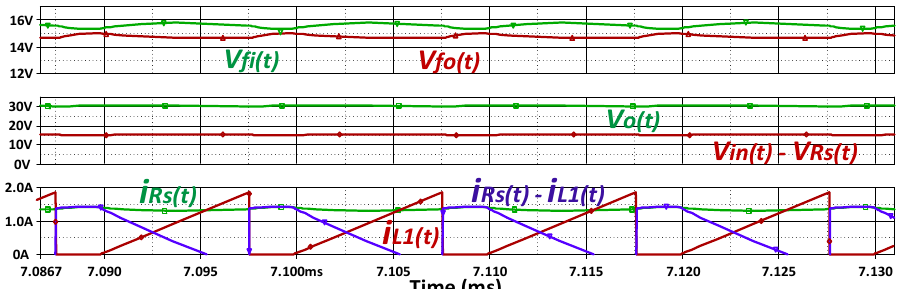
Figure 12. Simulation results. Input and output voltages of the flyback converter ( v fin (t), v fo (t) ); output voltage ( v o (t) ) and voltage of the TEGs ( v in (t)-v Rs (t) ); input current ( i Rs (t) ), current of the primary inductors( i L1 (t) ), and current that is delivered directly to the load ( i Rs (t)- i L1 (t) ).